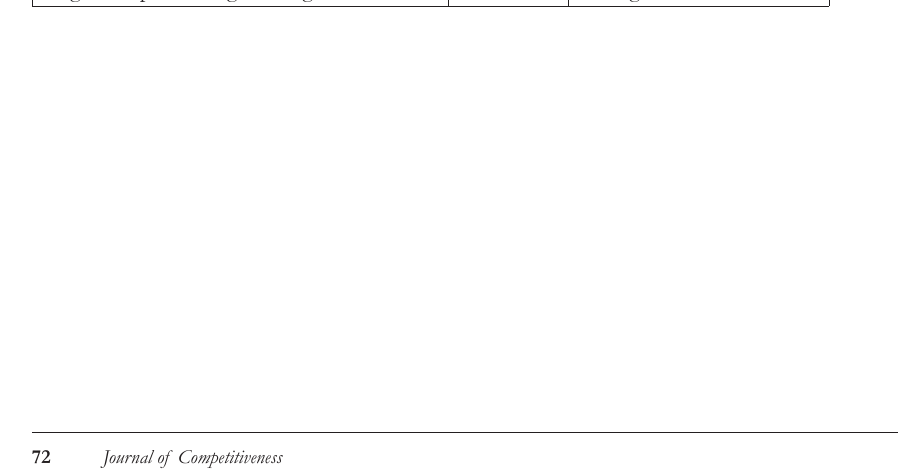
Tab. 6 - Strength of correlated variables. Source: own research Variable relationship Percent Strength of correlation Gender ↔ usage 11 moderate Age ↔ usage 5 weak Education ↔ usage 8 weak Degree of processing ↔ usage 75